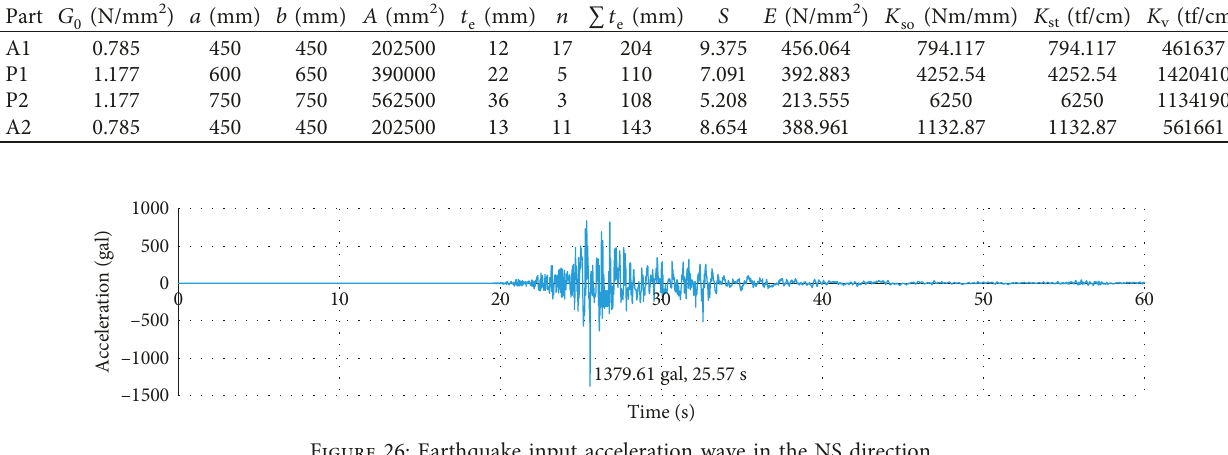
Figure 26: Earthquake input acceleration wave in the NS direction.